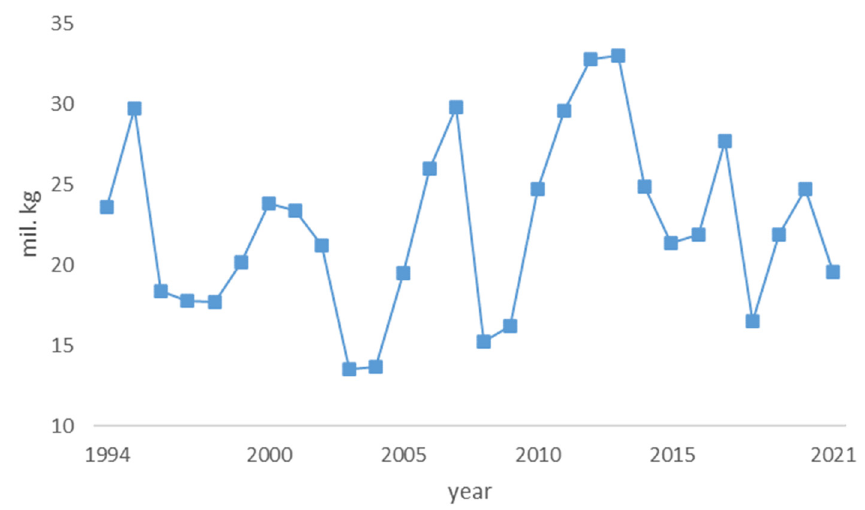
Figure 1. Quantity of wild mushrooms harvested in Czech forest between 1994 and 2021.